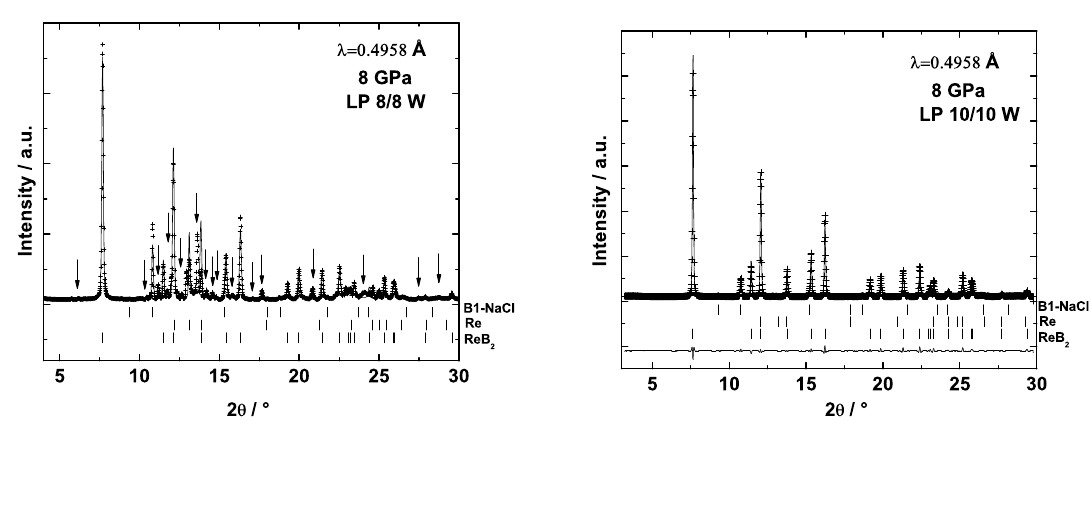
Figure 19. X-ray diffraction patterns after laser heating with different laser power a mixture of rhenium and boron in a DAC ( λ = 0.4958 ˚A). Left: Arrows indicate unidentified